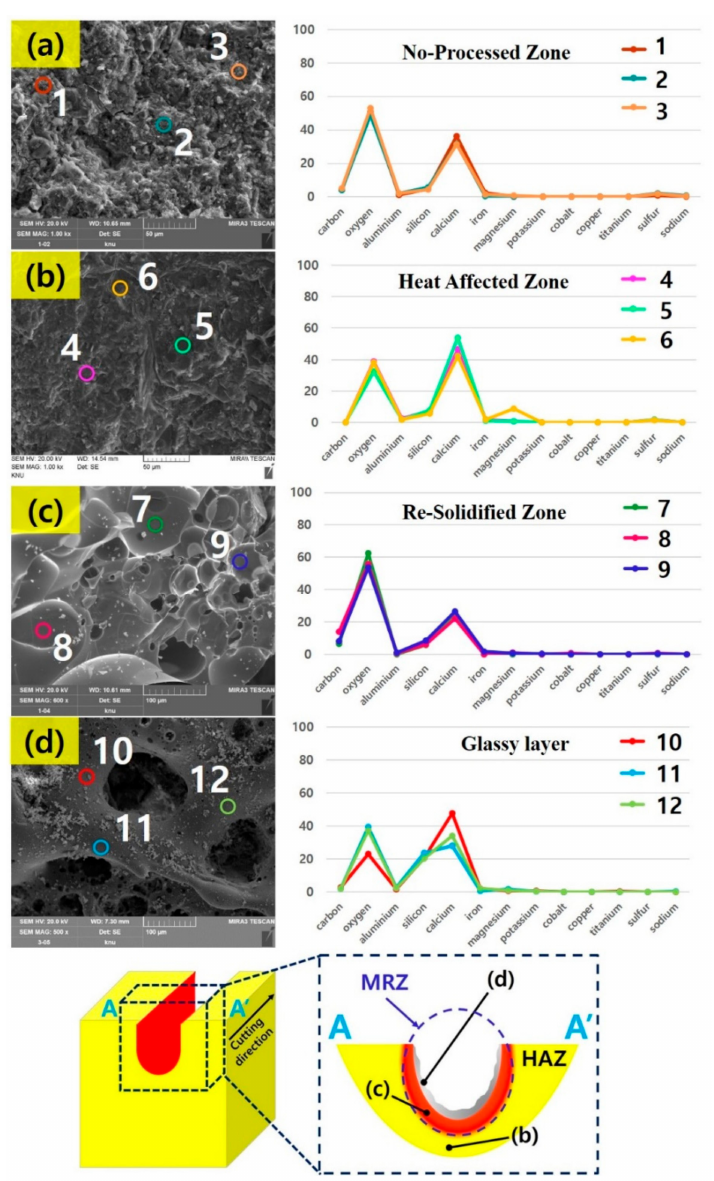
Figure 5. Energy dispersive X-Ray (EDX) analysis of ( a ) No Processed zone; ( b ) Heat A ff ected zone; ( c ) Re-solidified zone; ( d ) glassy layer in